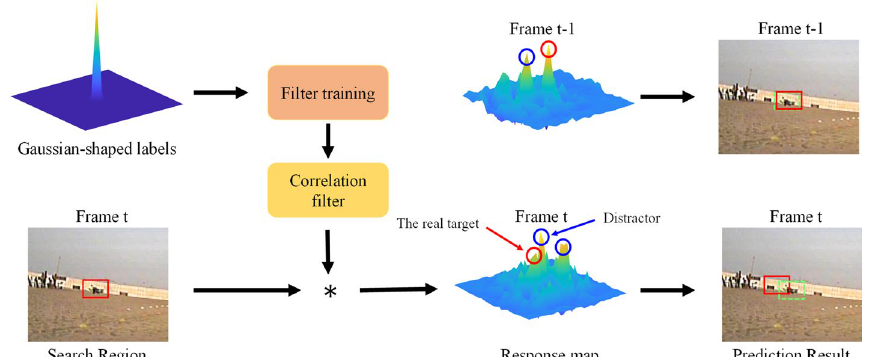
Fig. 1 An instance of the tracking results between consecutive frames of the baseline SRDCF tracker on the uav3 sequence from public UAV benchmark dataset. The red circle represents the real target, and the blue ones represent the distractors. The red bounding box denotes the baseline tracker output, while green dot one is the output of the ground